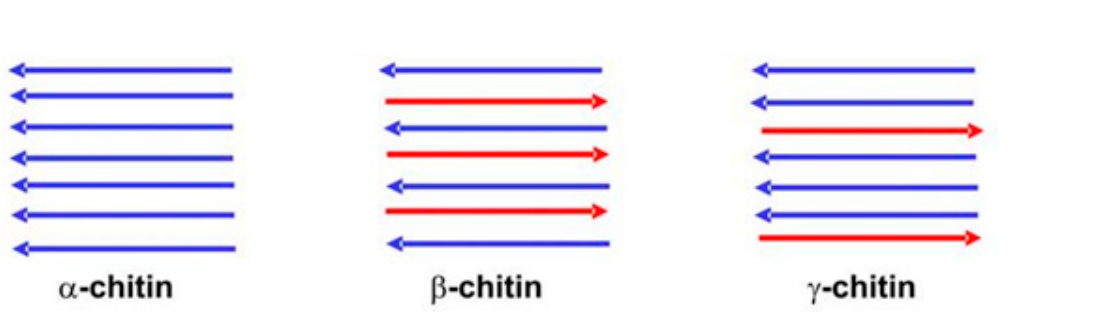
Figure 4. General scheme of chitin biosynthesis in biological systems.